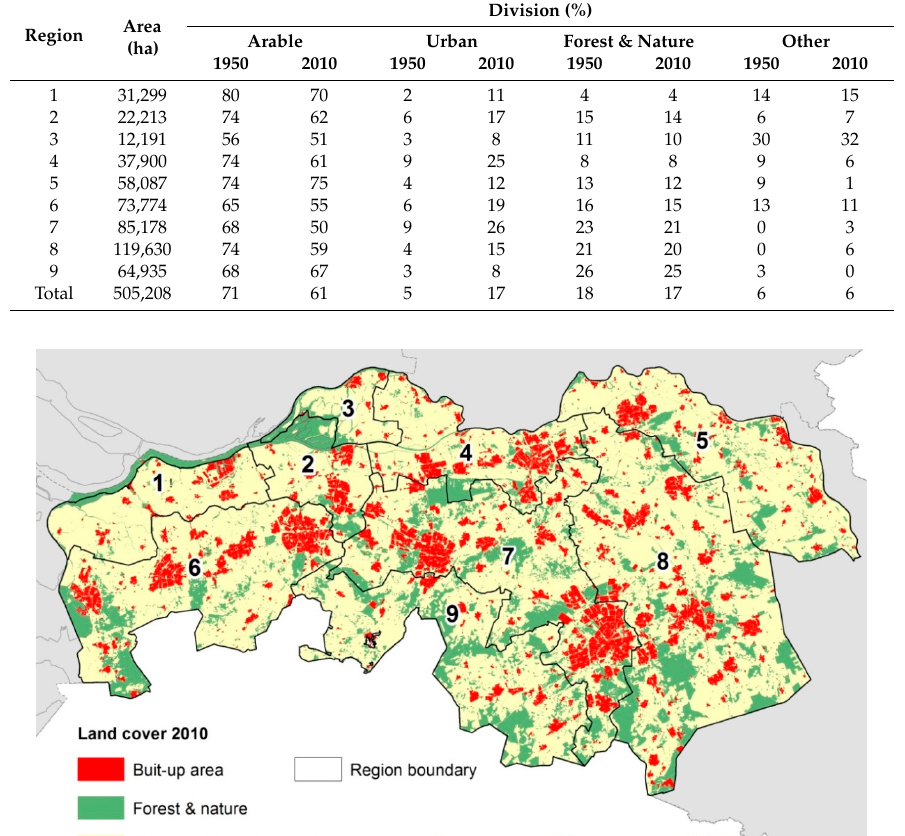
Table 1. Total area and division in main categories of land use of the regions of Figure 2. Source: CBS, 2010.